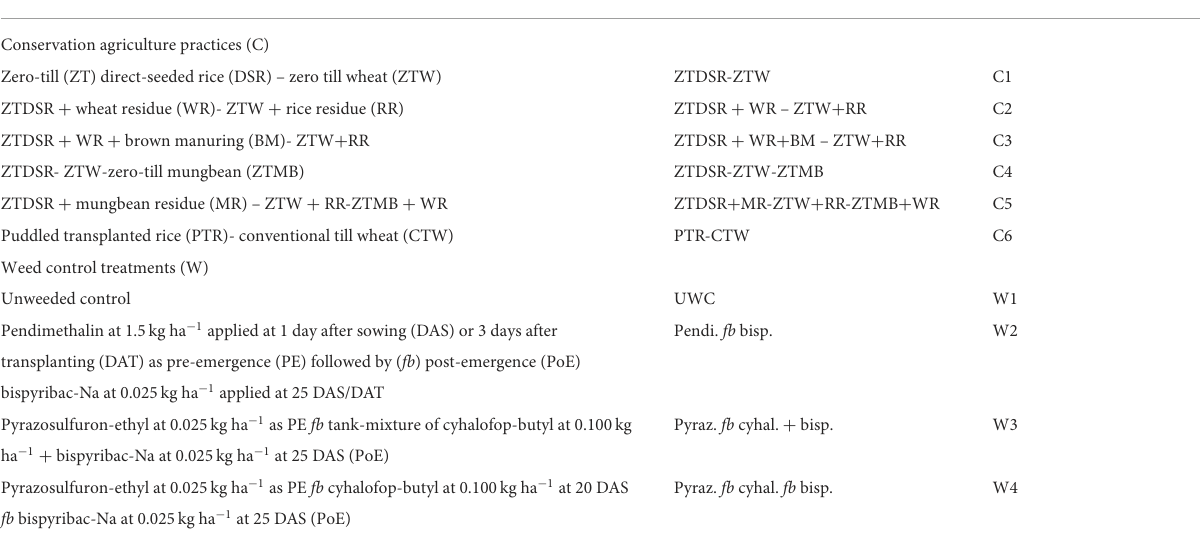
TABLE 1 Treatments adopted in the